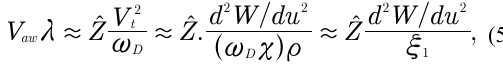
Figure 4. The meaning of the elastic-plastic invariant • elastic deformation stage; ■ linear work hardening tage; ▲easy glide stage; ♦ individual dislocation motion In view of / V X E t D 2 2 2 . . ~ t (here ω bye frequency; ρ , material density; E≈X -1 ·d 2 W/du 2 , elastic modulus; u << X , displacement and W ( u ), lattice po tential function 21 ), invariant (4) is rearranged